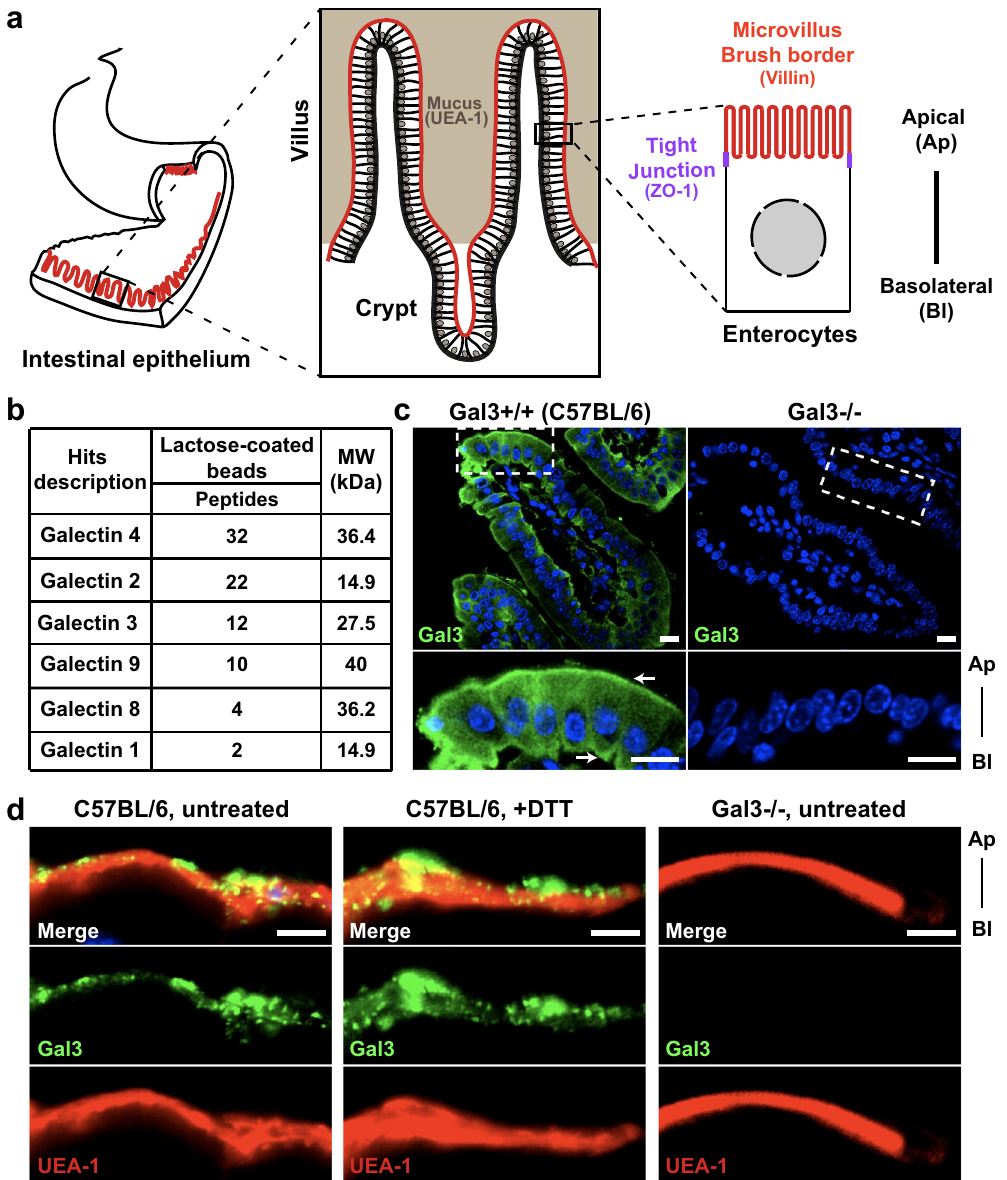
Fig. 1 Galectin expression in murine jejunum. a For our studies, the jejunum part of the mouse intestine was used as a model system. Schematic overview of the functional structure and features of the intestinal epithelium and of enterocytes. b Galectin expression pro fi le in the jejunum. MS results of galectins that were puri fi ed from jejunum cell lysates of C57BL/6 mice, using lactose-coated beads. c Localization of endogenous Gal3 (green). Transverse sections of Gal3 + / + (C57BL/6) mouse jejunum were analyzed by immunohistochemistry using an anti-Gal3 antibody. Gal3-de fi cient (Gal3 − / − ) mice were included as speci fi city controls. Insets represent the magni fi cation of a monolayer of cells. Nuclei were labeled with DAPI (blue). Scale bars: 10 μ m. d Gal3 localization within the mucosal barrier. Immunohistochemistry was performed using sections from Carnoy ’ s fi xed jejunum tissue obtained from Gal3 + / + (C57BL/6) or Gal3 − / − mice. Labeling with antibodies directed against Gal3 (green) or the mucus marker UEA-1 (red). The absence of Gal3 signal in Gal3 − / − conditions con fi rmed the speci fi city of the labeling. Note that DTT treatment did not perturb Gal3 or UEA-1 localizations. Scale bars: 5 μ